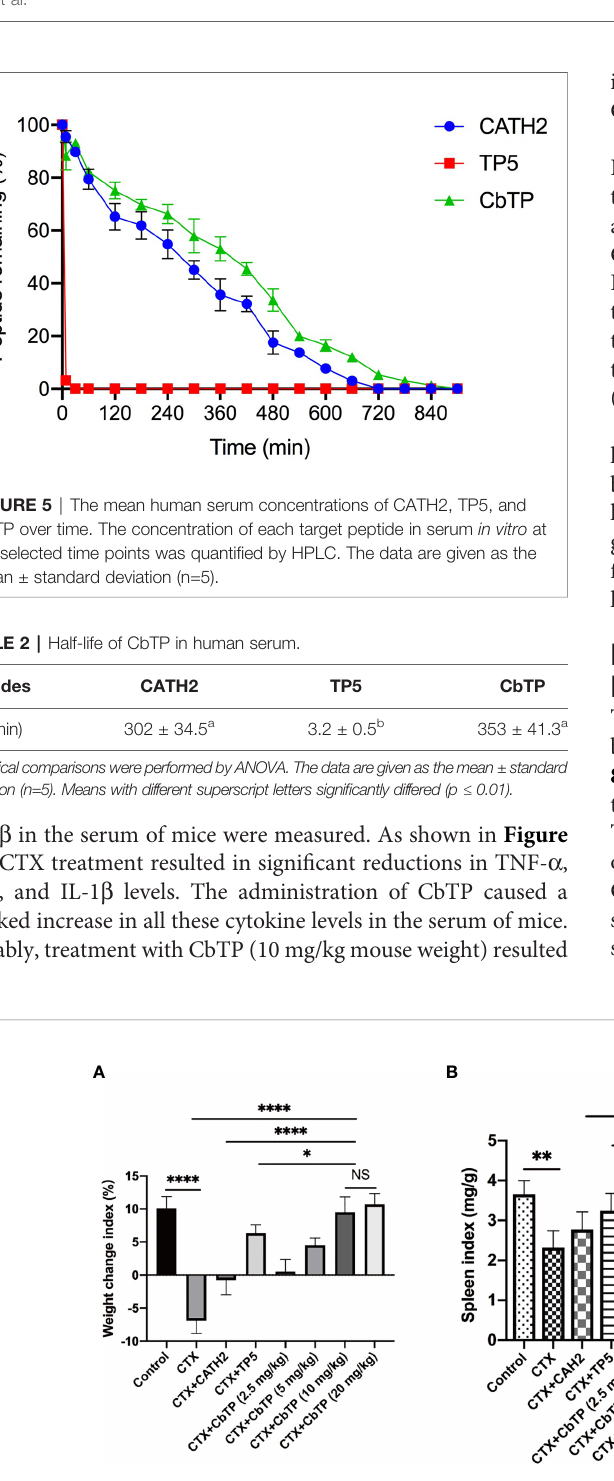
FIGURE 6 | The effects of CbTP on body weight (A) , spleen index (B) , and thymus index (C) . The mice were randomly divided into eight groups (12 mice in each group): control group: physiological saline was injected intraperitoneally once daily; cyclophosphamide (CTX) group: CTX (80 mg/kg mouse weight) was injected intraperitoneally once daily for the fi rst 3 days. From days 4 to 10, physiological saline was injected intraperitoneally into mice once daily; CTX + peptide (CATH2, TP5, or CbTP) group: CTX (80 mg/kg mouse weight) was injected intraperitoneally once daily for 3 consecutive days. From days 4 to 10, the parental peptide (CATH2 and TP5; 10 mg/kg mouse weight) or CbTP peptide (2.5, 5, 10 or 20 mg/kg mouse weight) was injected intraperitoneally into mice once daily. The body weight was recorded before and after the experiment. The spleen weights and thymus weights of the mice were examined after 10 days treatment. Statistical comparisons were performed by Student ’ s t test. The data are shown as the mean ± standard deviation (n=12). NS, p > 0.05; *p ≤ 0.05; **p ≤ 0.01; ***p ≤ 0.001; and ****p ≤